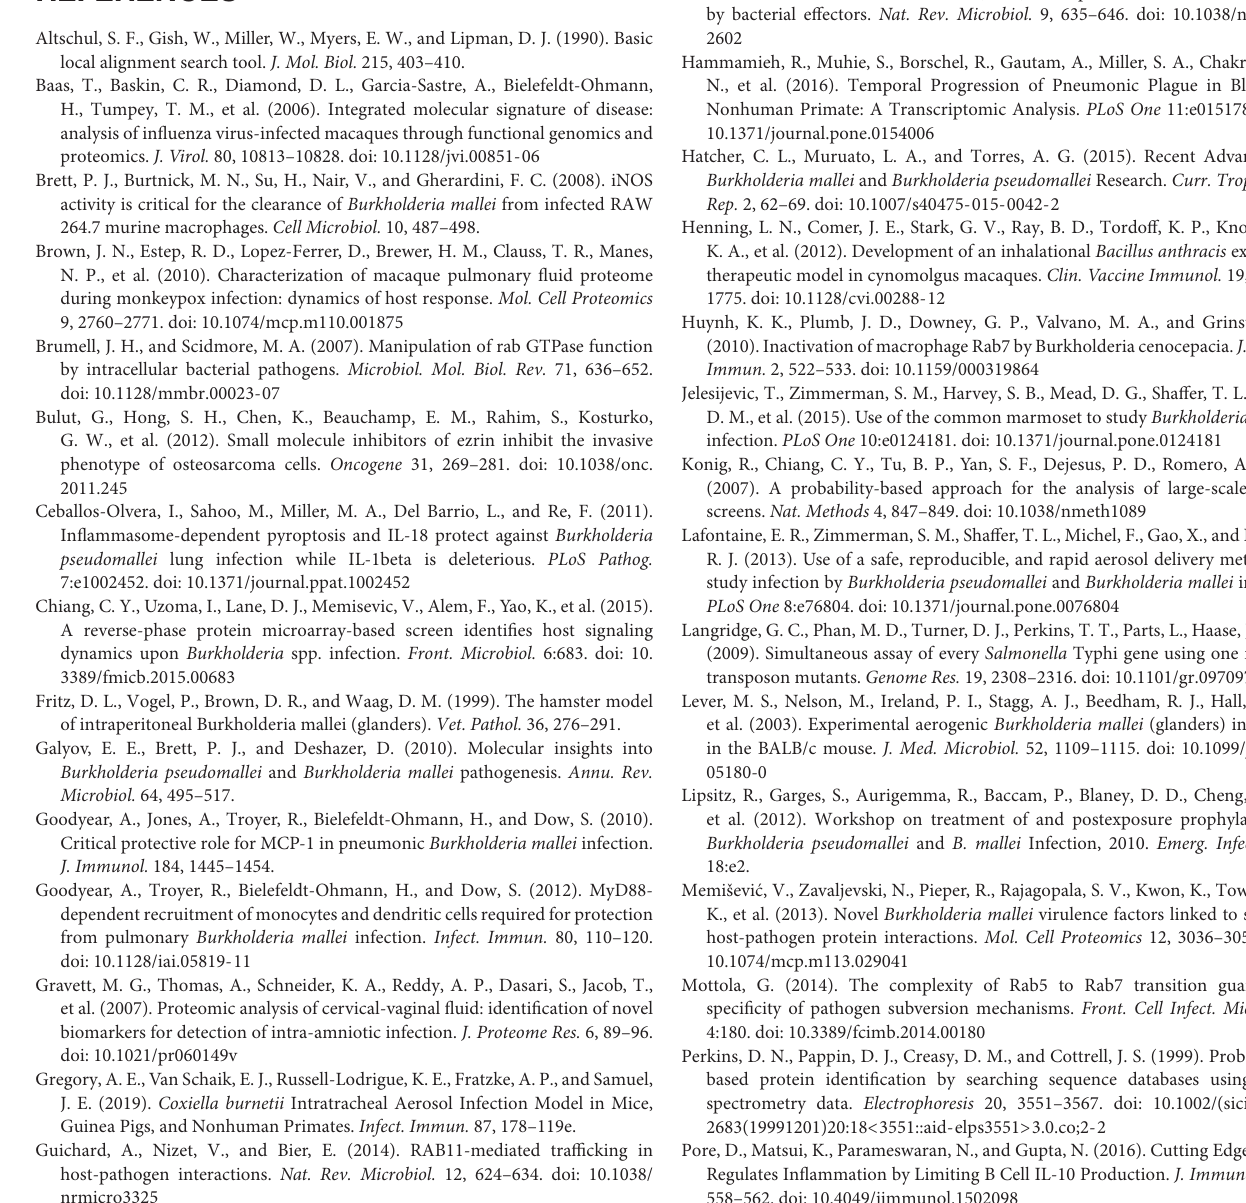
After filtering out redundant genes, 3,288 unique genes were retained for downstream analyses. Supplementary Figure 2 | B. mallei mediated pro-inflammatory gene expressions. Two hours before B. mallei infection, mBMDM were pretreated with ezrin inhibitor at various concentrations. Total RNAs were extracted 5 h post infection and the expression level of indicated genes were quantified by real-time PCR. Supplementary Table 1 | The time of PMBCs that were collected post infections. Supplementary Table 2 | The primer sequences used for the real-time PCR in this study.